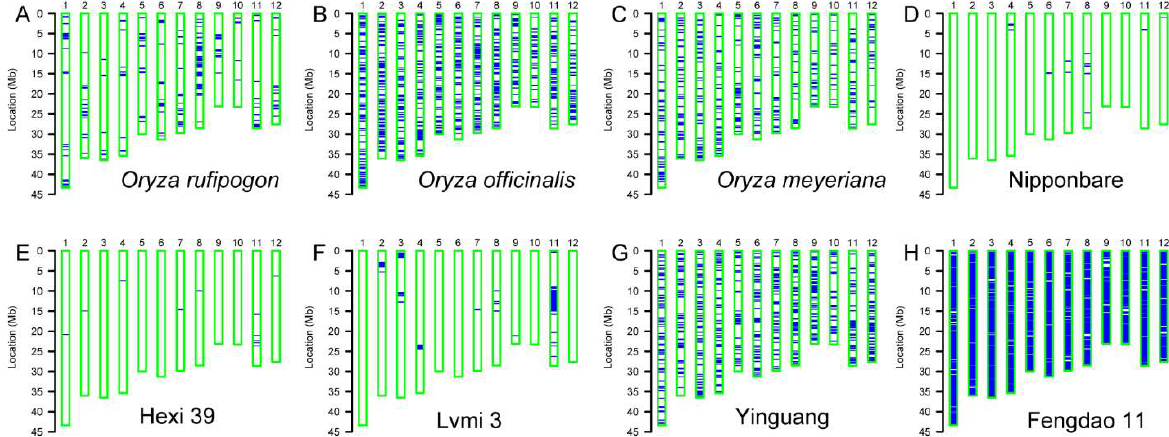
Figure 3. Background analysis with whole-genome SNP array. The background map of wild rice accessions ( A – C ), the control variety Nipponbare ( D ) and several representative varieties ( E – H ). The 12 chromosomes are indicated with blue bars. Empty bars with a green border represent the homozygous background, and blue lines or bars represent the heterozygous fragments.